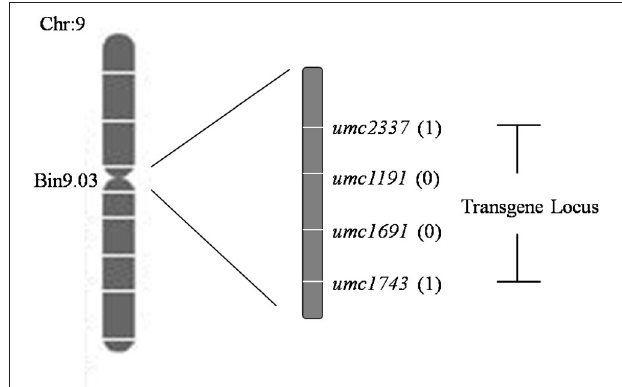
FIGURE 6 | Deduced locations of the simple sequence repeat (SSR) markers and transgenes. The name of each marker is listed on the right side of the map. The number of recombinants is given after each corresponding marker.